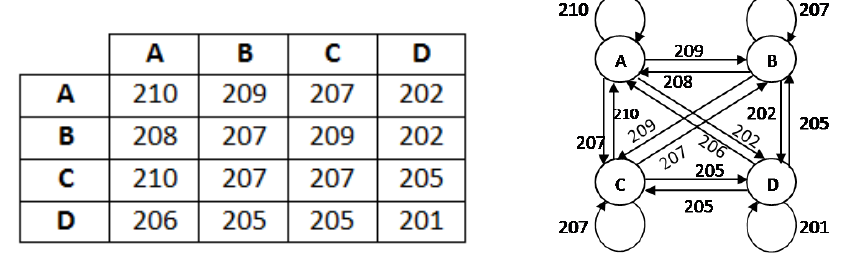
( c ) Figure 4. Skin lesion pre-processing method. ( a ) Input image IMD002, ( b ) hair removal by DullRazor algorithm, ( c ) enhanced image. 4.3. Segmentation After complete pre-processing of the image, the boundary of the affected area is identified by the process of segmentation. Image segmentation is done for dissection of the primary affected area with high correlation and Region of Interest (RoI). The conventional state-of-art skin lesion segmentation methods like thresholding, region enhancing and clustering did not quite succeed in resolving the complex issues concerning melanoma detection and fell apart mainly owing to their time and computational complexity. As time progressed, these conventional methods were gradually taken over by several well-known methods namely automated computer aided method, k-mean algorithm, convolution, saliency and deconvolution networks [30–36] and segmentation algorithms like edge detection, thresholding and active contour methods. In recent times, active contour algorithms based on parametric or geometric curve tracking methods have gained immense